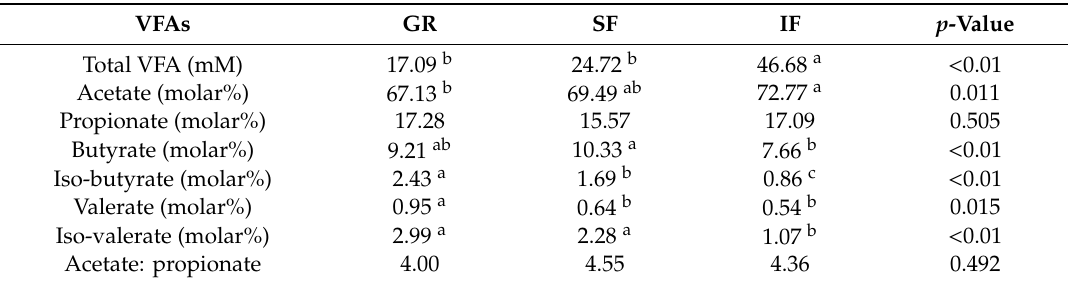
Table 1. Concentrations of volatile fatty acids (VFAs) in the rumen fluid of the goat kids among the three feeding